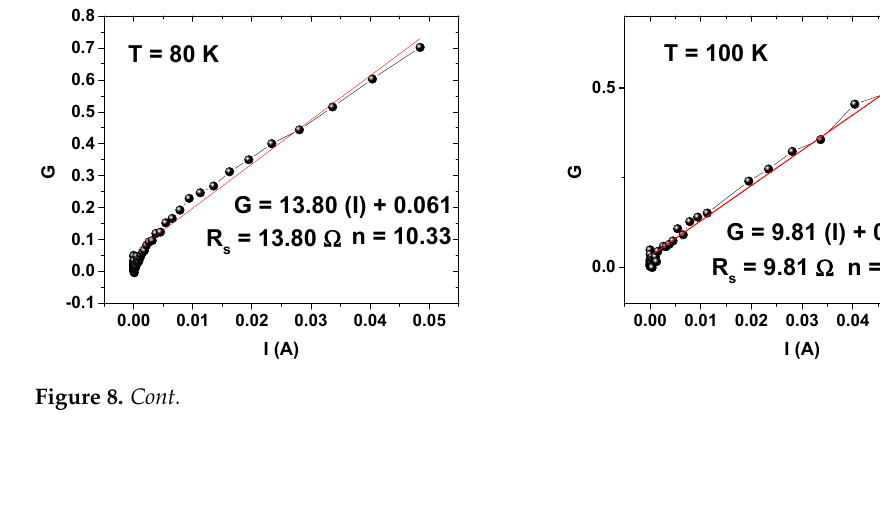
Figure 7. φ b versus n . Figure 7. ɸ b versus n .